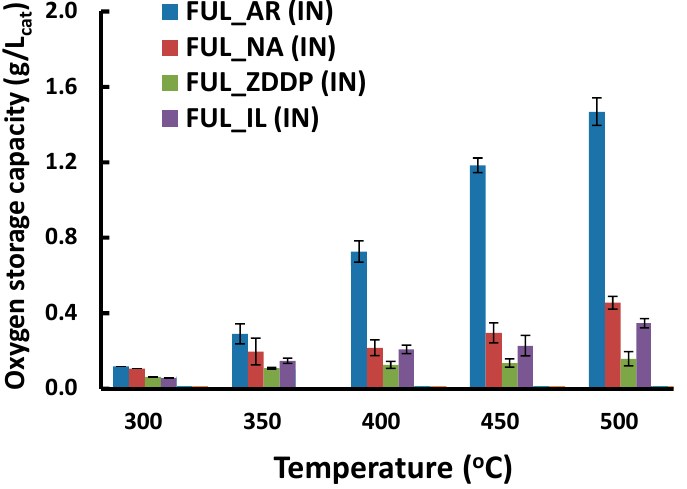
Figure 11. Oxygen storage capacity (OSC) for FUL_AR, FUL_NA, FUL_ZDDP, and FUL_IL.